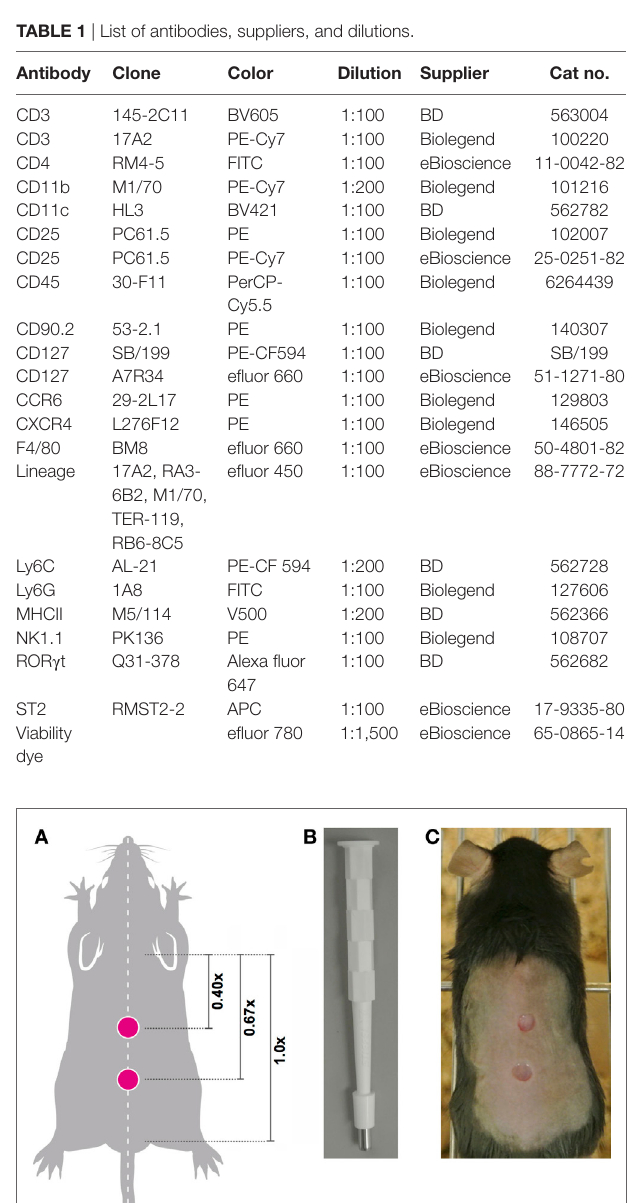
tABLe 1 | List of antibodies, suppliers, and dilutions.